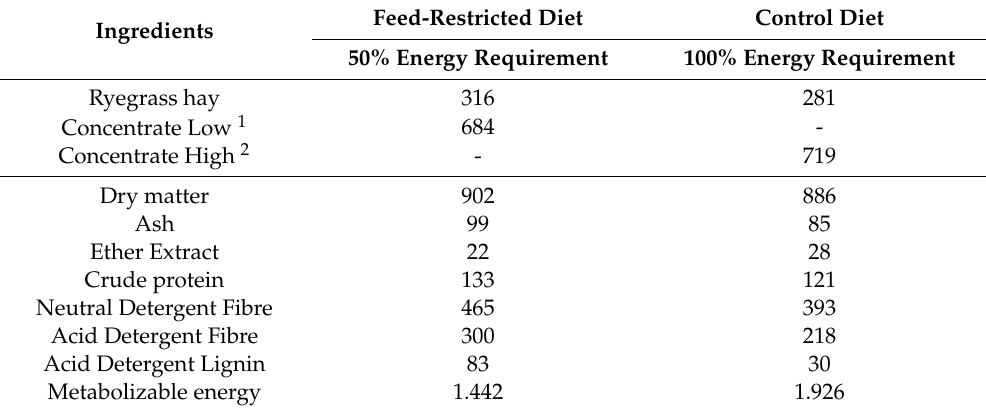
Table 1. Ingredients (g / kg), diet chemical composition (g / kg), and estimated metabolizable energy (Mcal /